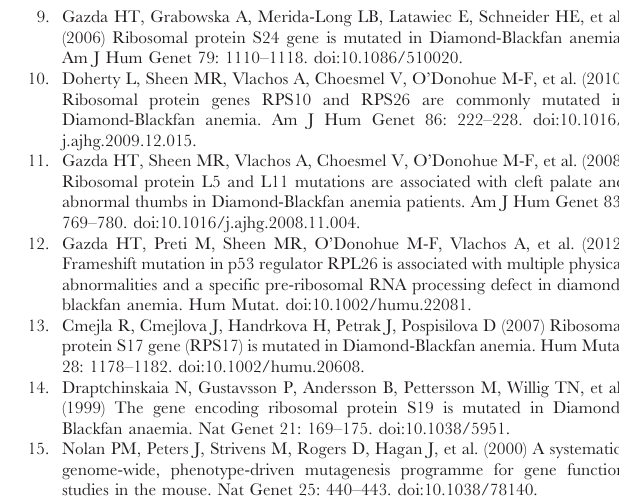
Figure S9 Rps7 mutants have pyknotic nuclei in the spinal cord. H&E stained sagittal sections through the spinal cord of E18.5 Rps7 + / + (A, B) and Rps7 Zma/ + (C, D) embryos. Arrow in D indicates Figure S10 Rps7 mRNA expression pattern. Mouse Rps7 transcript was detected by in situ hybridization at E13.5 (A, E), E16.5 (B, F), E17.5 (D), and adulthood (C, G). Broad expression was detected in the developing embryo, including a high level of expression in the ganglionic eminences (arrowhead in D), the proliferative ventricular zone (E), as well as in the dentate gyrus on the hippocampus in adult animals (G). Abbreviations: ventricular zone/subventricular zone (VZ/SVZ), intermediate zone (IZ), cortical plate (CP), CA3 region of hippocampus (CA3), dentate gyrus (DG). Figure S11 Rps7 mutants have increased TRP53 expression. (A– C) Increased TRP53 expression was detected in E11.5 Rps7 Zma / + (Z/ + ) coronal sections through the neocortex compared to Rps7 + / + ( + / + ) and Rps7 Zma / + ; Trp53 KO / + (Z/ + ;p53/ + ). (D–I) This increase was also detected in the neural tube of Rps7 Zma / + embryos at E11.5 (D–F) and E12.5 (G–I). Scale bars = 100 m m. (TIF) Table S1 Circulating blood counts from + / + and Rps7 Mtu / + adult male mice. Table S2 Biochemical panel from + / + and Rps7 Mtu / + adult male mice. Table S3 Rps7 Zma / + erythrocytes are able to terminally differentiate, but they display modest developmental delay that is suppressed by Trp53 haploinsufficiency.